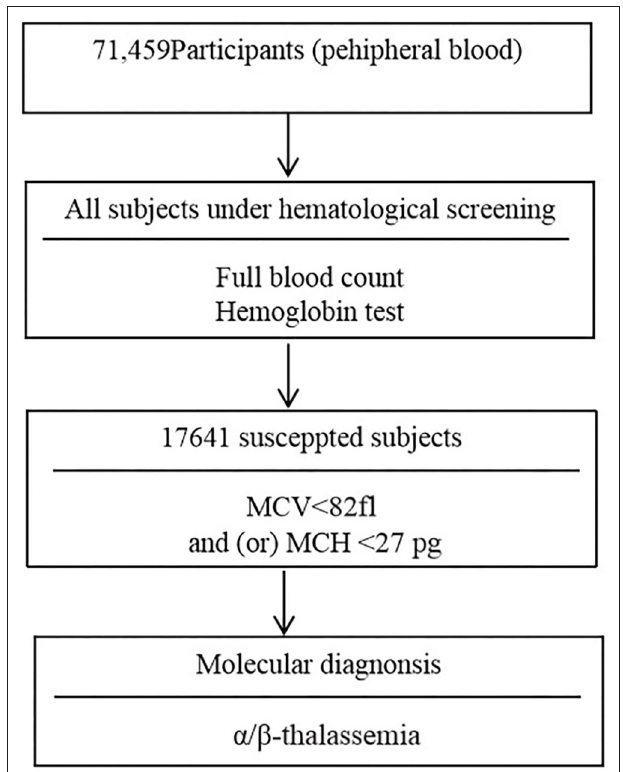
FIGURE 1 | Diagram for the screening of α / β